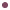
CPU times for various levels of overflow metabolism.(A) iMM904 (Saccharomyces cerevisiae), and (B) iJR904 (Escherichia coli). Data points are color coded as • MaxEnt, • Geometric, • flux sampling and • MinFlux. Δ corresponds to mutated strains overproducing acetate. 1000 samples were used in flux sampling.